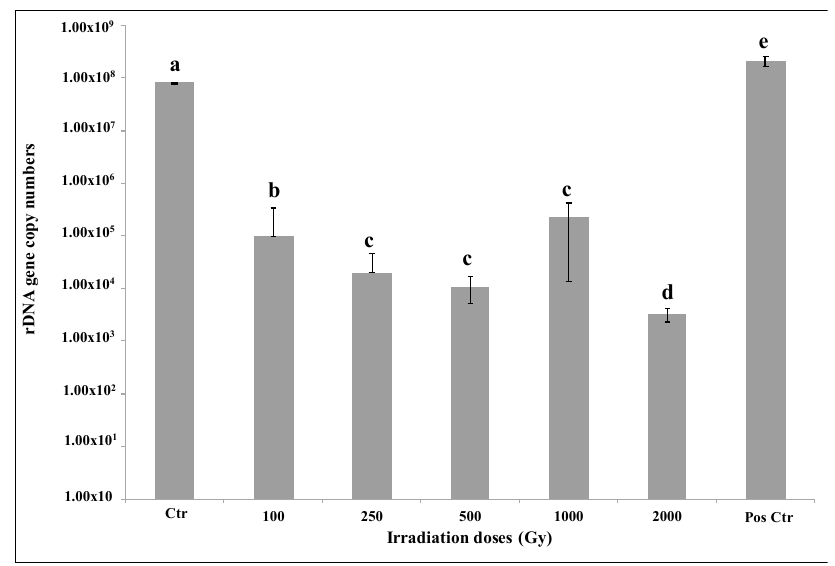
Figure 4. Quantitative PCR of a 939 bp (base pair) target gene (LSU) of C. antarcticus DNA after exposure to Fe ions irradiation. Pos Ctr = DNA of C. antarcticus colony growth in physiological conditions. Statistical analysis as in Figure 1.